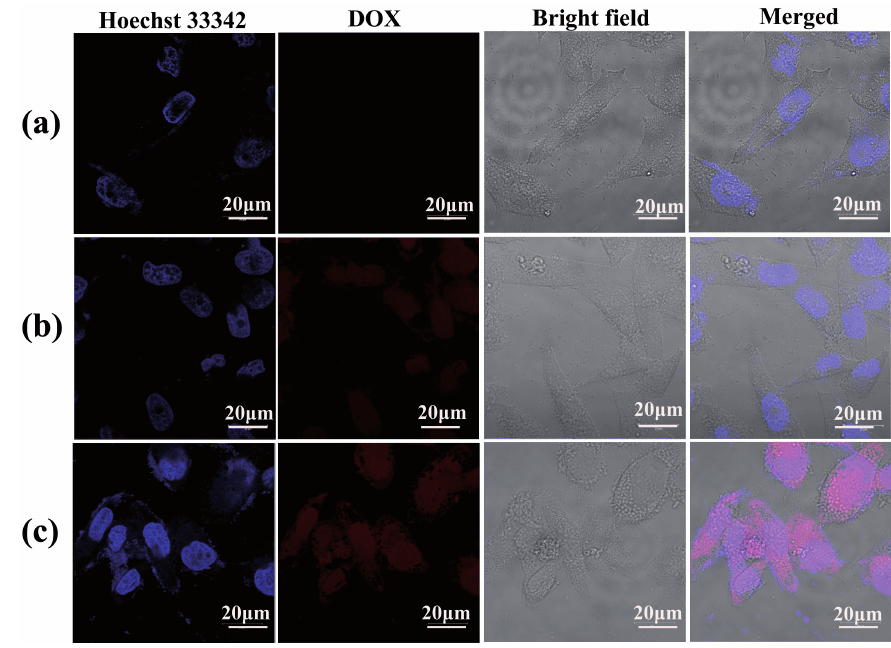
Figure 9. Confocal laser scanning microscopy (CLSM) images of KB cells treated with ( a ) PBS (control), ( b ) free DOX and ( c ) LM-G2/DOX nanodisks with a DOX concentration of 0.6 μM for 4 h at 37 °C. KB cells treated with PBS were used as